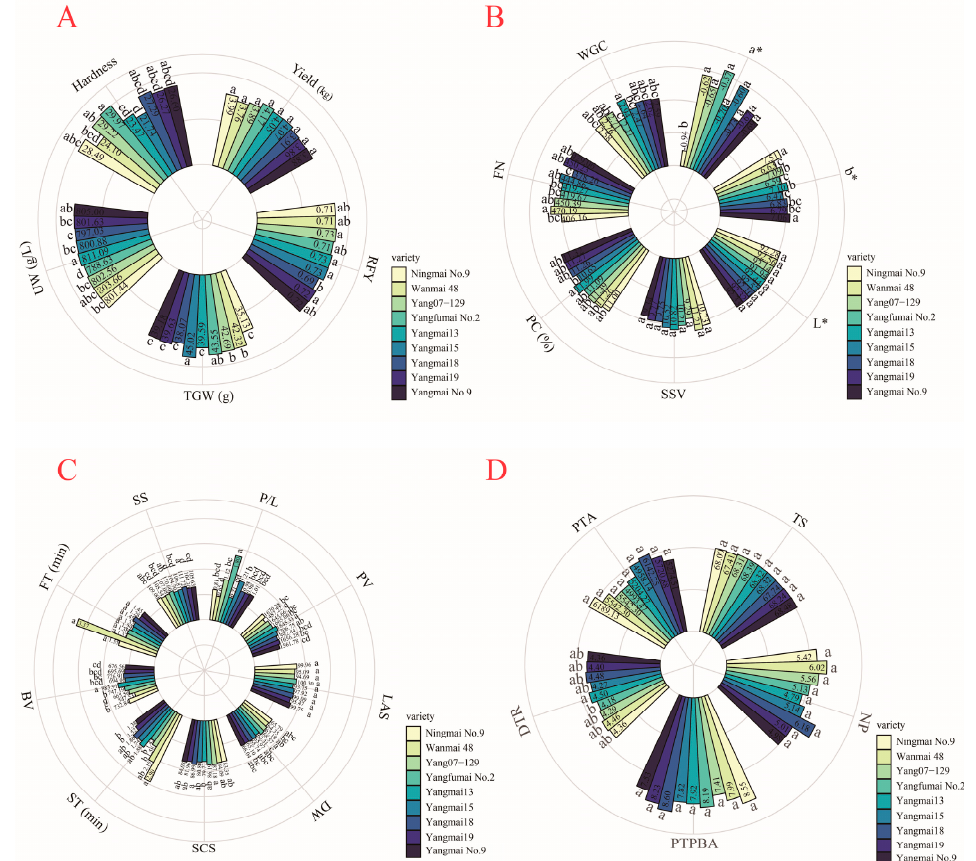
Figure 5. Traits of the nine tested weak-gluten wheat varieties. ( A – D ) Comparison among nine wheat varieties in yield- and grain-related traits: ( A ) including yield, TGW, UW, hardness, and RFY), physical and chemical properties ( B ); including PC, WGC, SSV, FN, L*, a*, and b*), rheological properties of dough, and solvent retention ( C ); including FT, ST, PV, BV, P/L, DW, SS, SCS, and LAS) and properties of Chinese crisp biscuits and American cookies ( D ); including TS and PTPBA for Chinese crisp biscuits, and NP, DTR, and PBA for American cookies). TGW, thousand-grain weight; UW, unit weight; RFY, rate of flour yield; PC, protein content; WGC, wet gluten content; SSV, SDS sedimentation value; FN, falling number; L*: brightness; a*: redness; b*: yellowness; FT, formation time; ST, stabilization time; PV, peak viscosity; BV, breakdown value; P/L, blowing instrument parameter. DW, SS, SCS, and LAS denote retention capacity of flour with de-ionized water (DW), sucrose solution (SS), sodium carbonate solution (SCS), and lactic acid solution (LAS) as the solvent, respectively. TS, tasting score; PTPBA, the parameter from the three-point bending texture analyzer; NP, number of patterns; DTR, diameter-thickness ratio; PTA, the parameter from the Texture Analyzer. Different lowercase letters indicate the significance of the